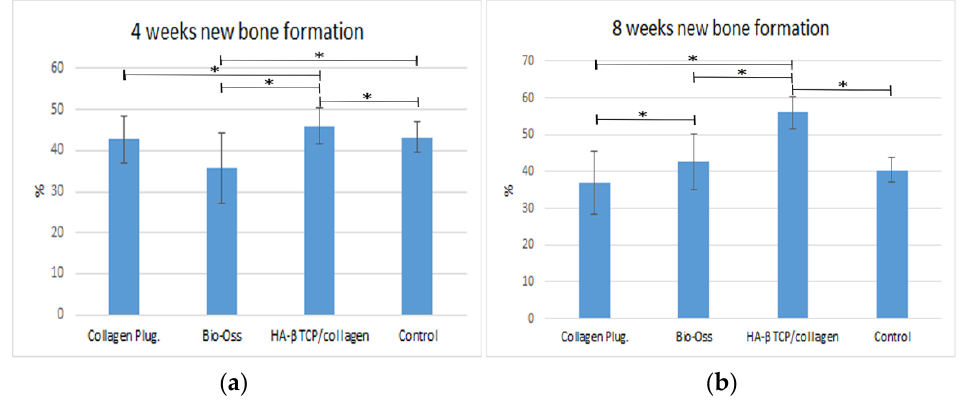
Figure 9. New bone formation. Average of new bone formation (bone volume/tissue volume) at four ( a ) and eight weeks ( b ). * p < 0.05.